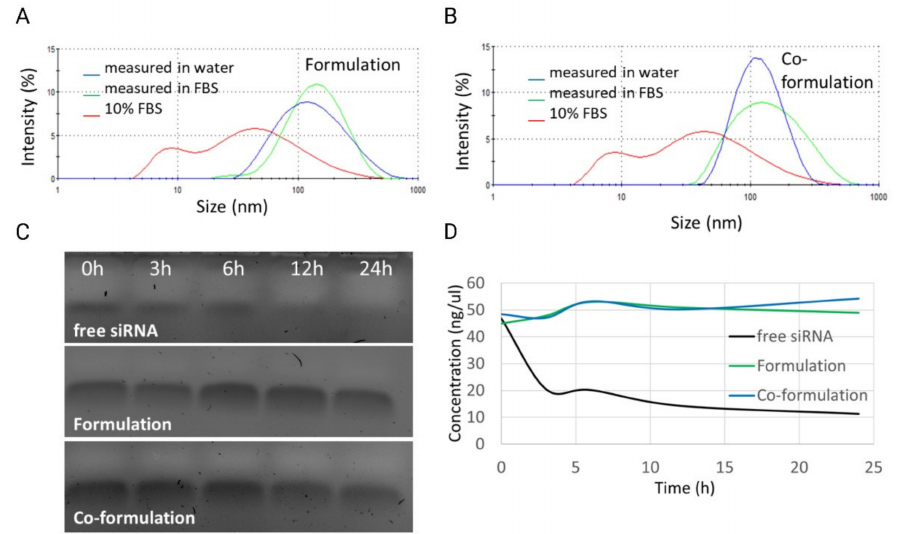
Figure 4. CD-NP stability in serum. ( A ) Particle size measurement after 24 h incubation in 10% serum for formulation MR 8.5:1 (cationic CD:siRNA). ( B ) Particle size measurement after 24 h incubation in 10% serum for formulation co-formulation MR 8.5:1:5.3 (cationic CD:siRNA:anionic CD). ( C ) siRNA displacement assay of serum-treated NPs with polyanion Heparin to confirm the ability to protect siRNA in CD-NP. ( D ) Quantification of siRNA of serum- and heparin-treated NP with NanoDrop